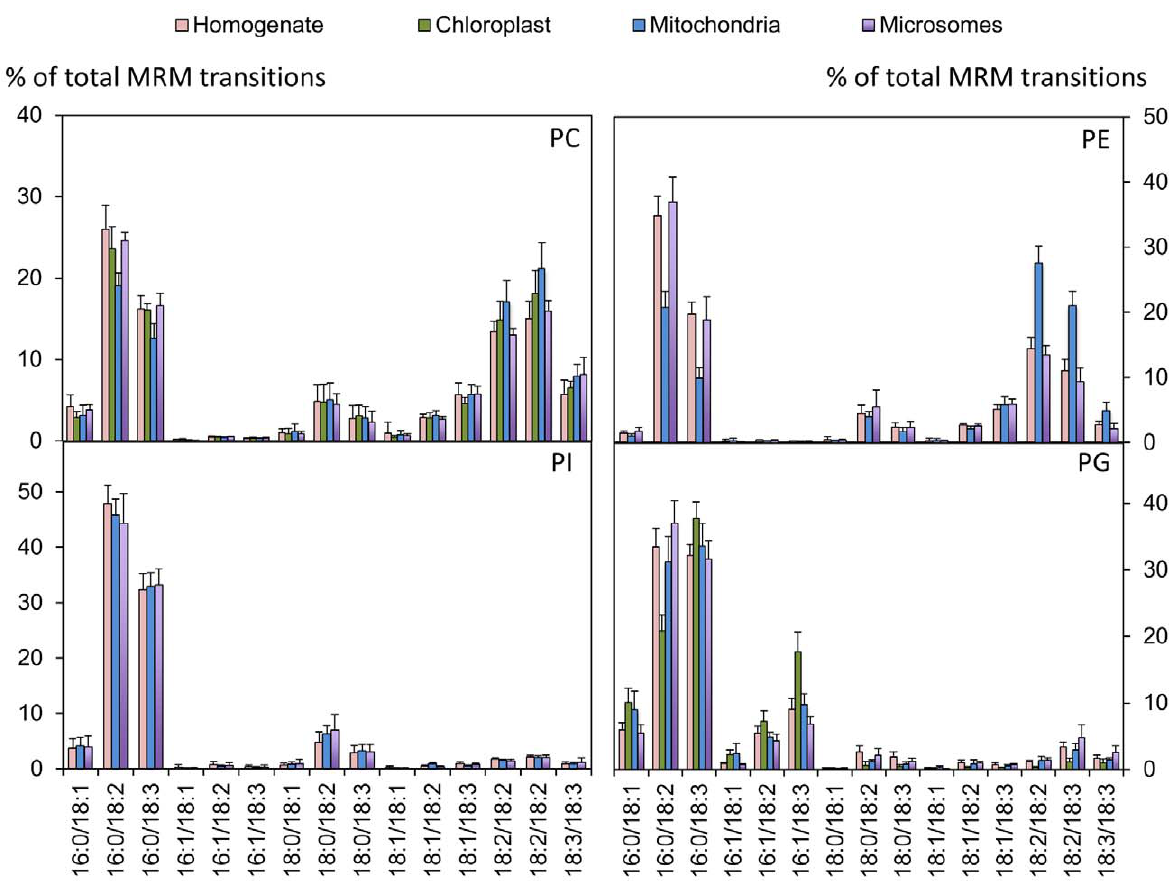
Figure 7. Profiles of PE, PC, PG and PI as analyzed by MRM mass spectrometry in different membrane fractions. N =14, 13, 9 and 4 for homogenate, microsomes, plasma membrane enriched fractions and mitochondria-enriched fractions, respectively. Note that there is no PI or PE in chloroplasts, and that the signals obtained were omitted because they were due to contamination. Diagrams of the molecular species in all analyzed fractions can be found in Figure